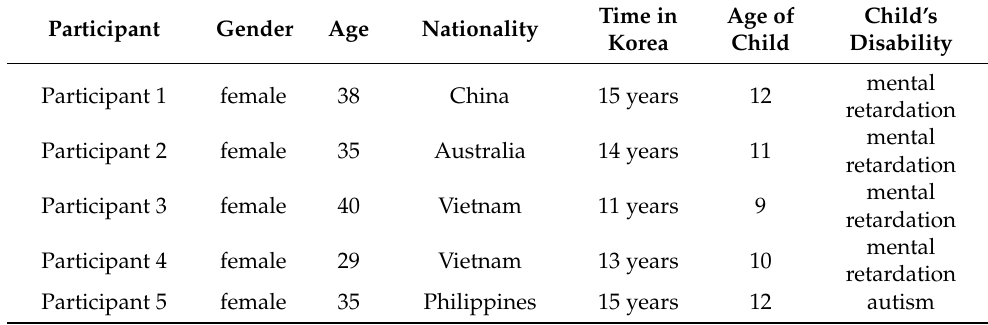
Table 1. Research Participant